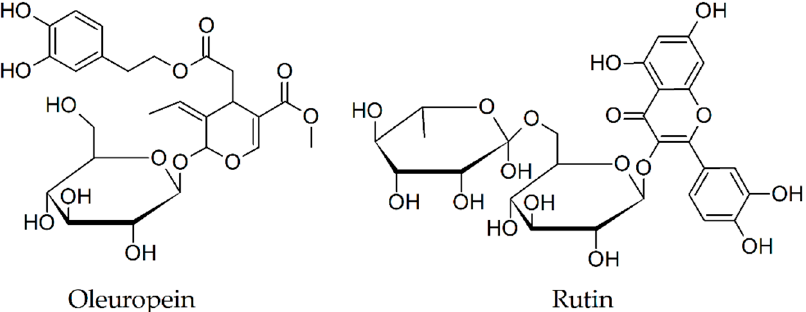
Figure 5. Chemical structures of oleuropein and rutin.